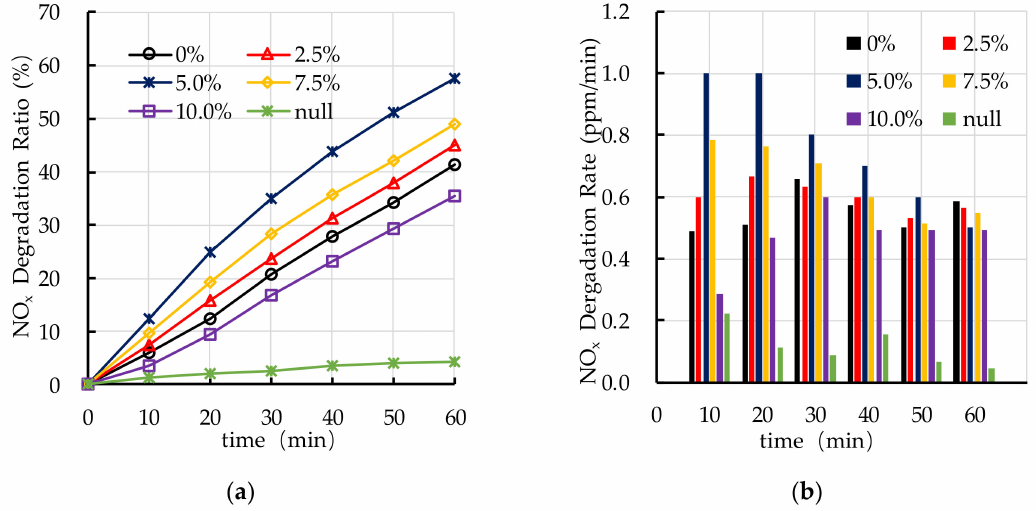
Figure 17. E ff ect of dispersant dosage on photocatalytic degradation of NO x : ( a ) NO x degradation ratio; ( b ) NO x degradation